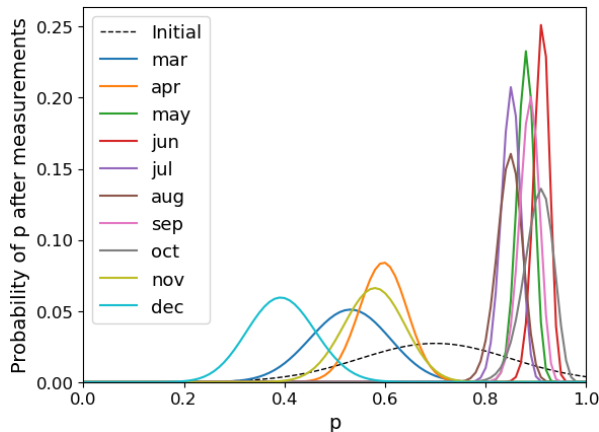
Figure A1. Pr (p | meas ) as a function of the cloud occurrence fre- quency p . The dashed black line corresponds to the a priori distribu- tion. The updated distributions for each month (Eq. A1) are shown in